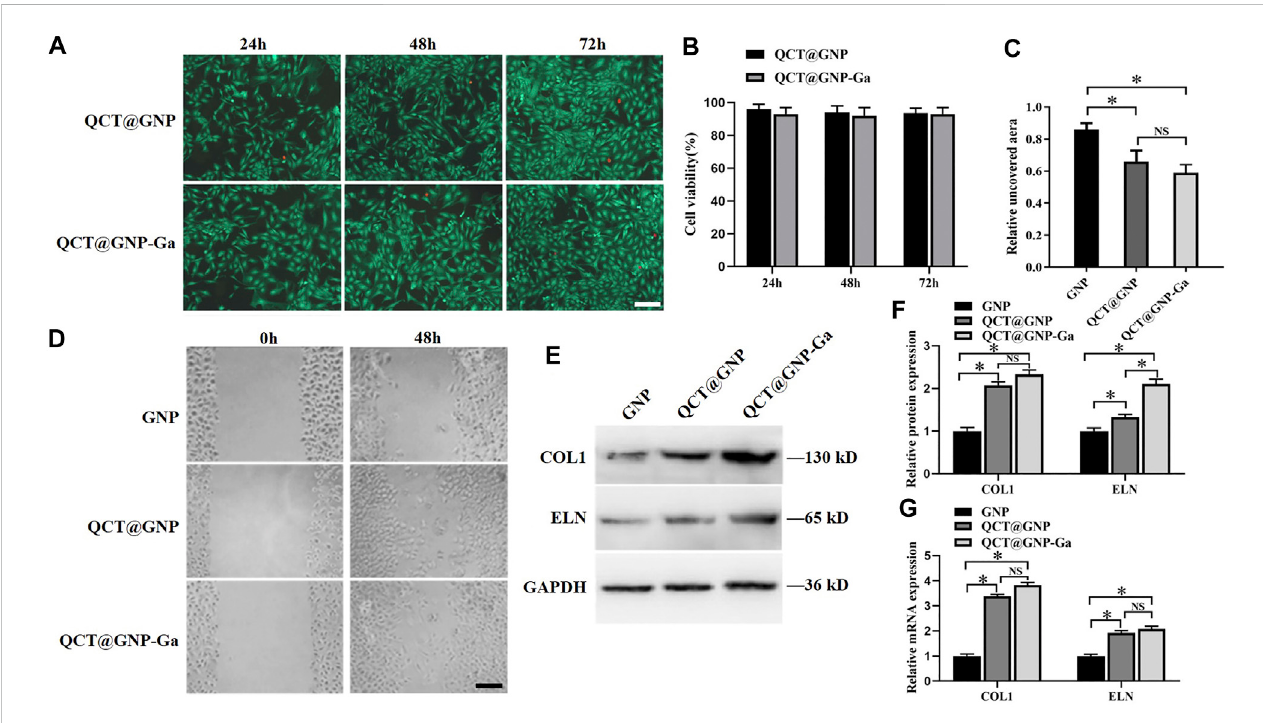
FIGURE 2 Effect of QCT@GNP-Ga on the cell function of primary fi broblasts. (A) Live/dead staining of fi broblasts treated with QCT@GNP or QCT@GNP-Ga. Scale bar = 100 μ m. (B) Cell viability of fi broblasts treated with QCT@GNP or QCT@GNP-Ga for 24, 48, and 72 h. (C) The uncovered aera and (D) representative images ofwound-healingassay of fi broblaststreated withGNP,QCT@GNPorQCT@GNP-Ga. (E) Western blotanalysis and (E) statistical resultsofCOL1, ELN protein expressions in fi broblasts treated with GNP, QCT@GNP or QCT@GNP-Ga. (G) qRT-PCR analysis of COL1, ELN mRNA expressions in fi broblasts treated with GNP, QCT@GNP or QCT@GNP-Ga for 48 h. Data are shown as mean ± SD, * p < 0.05 compared with GNP